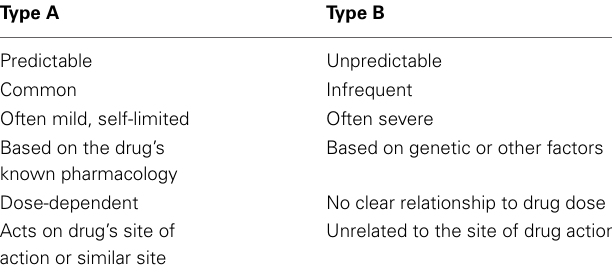
Table 2 | Classification of adverse drug